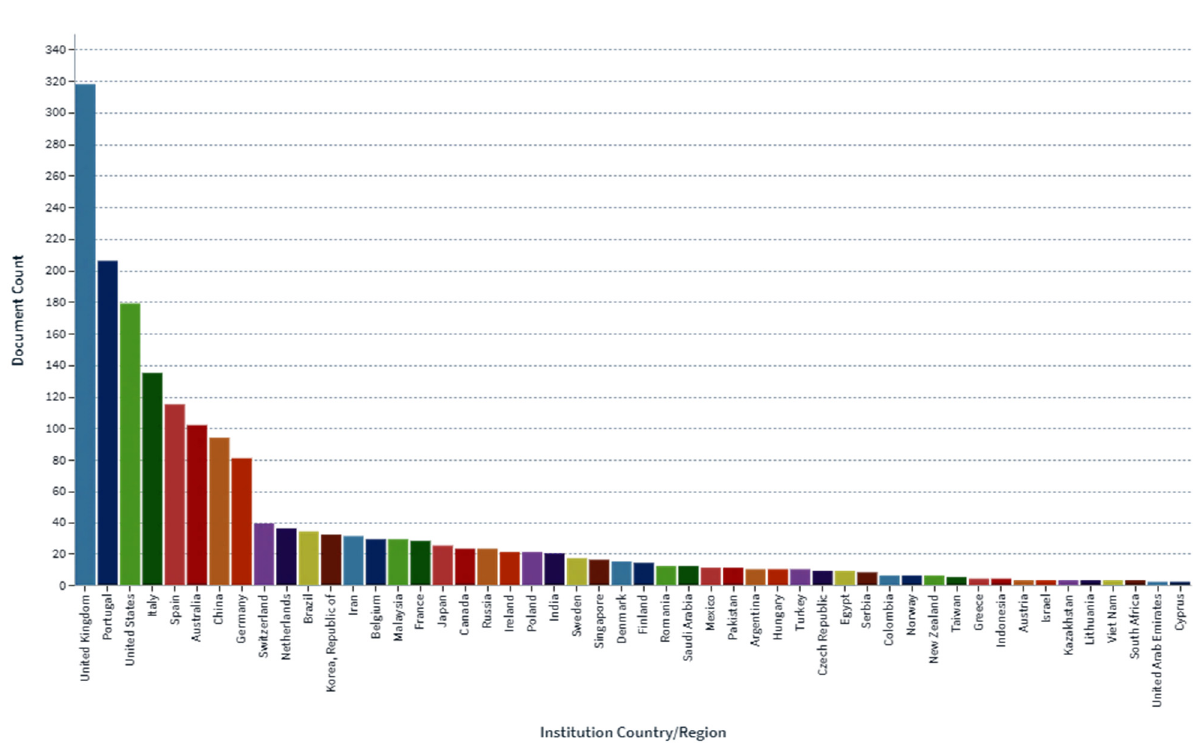
Figure 17. ( a ) Number of papers published ( n = 88) according to the author’s institute. ( b ) Number of papers published ( n = 88) according to the author’s institute and field of study.